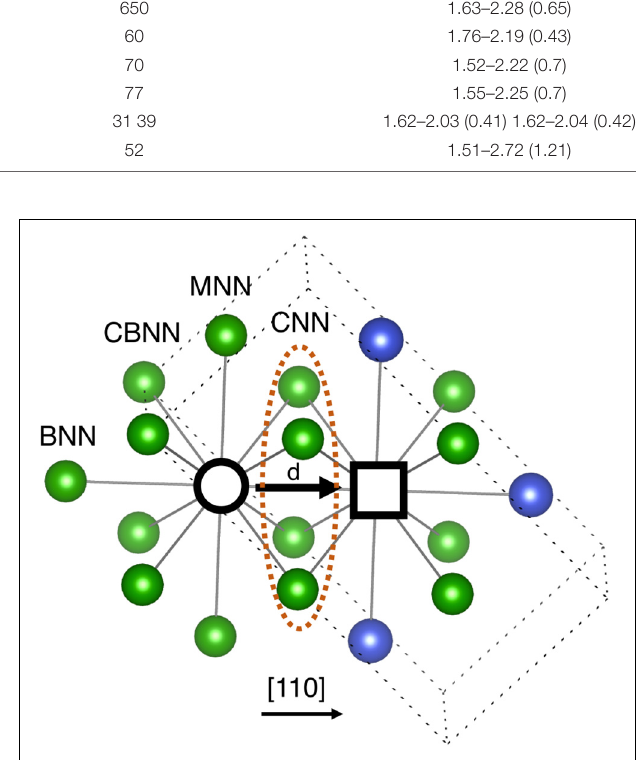
FIGURE 1 | Schematic representation of local chemical environment around a migrating atom and vacancy. Black empty circle and square represent migrating atom and vacancy, respectively. Four CNN atoms are the common first nearest neighbors to both vacancy and migrating atom. There are two MNN, four CBNN and one BNN (1NN) atoms for migrating atom and vacancy separately. See text for